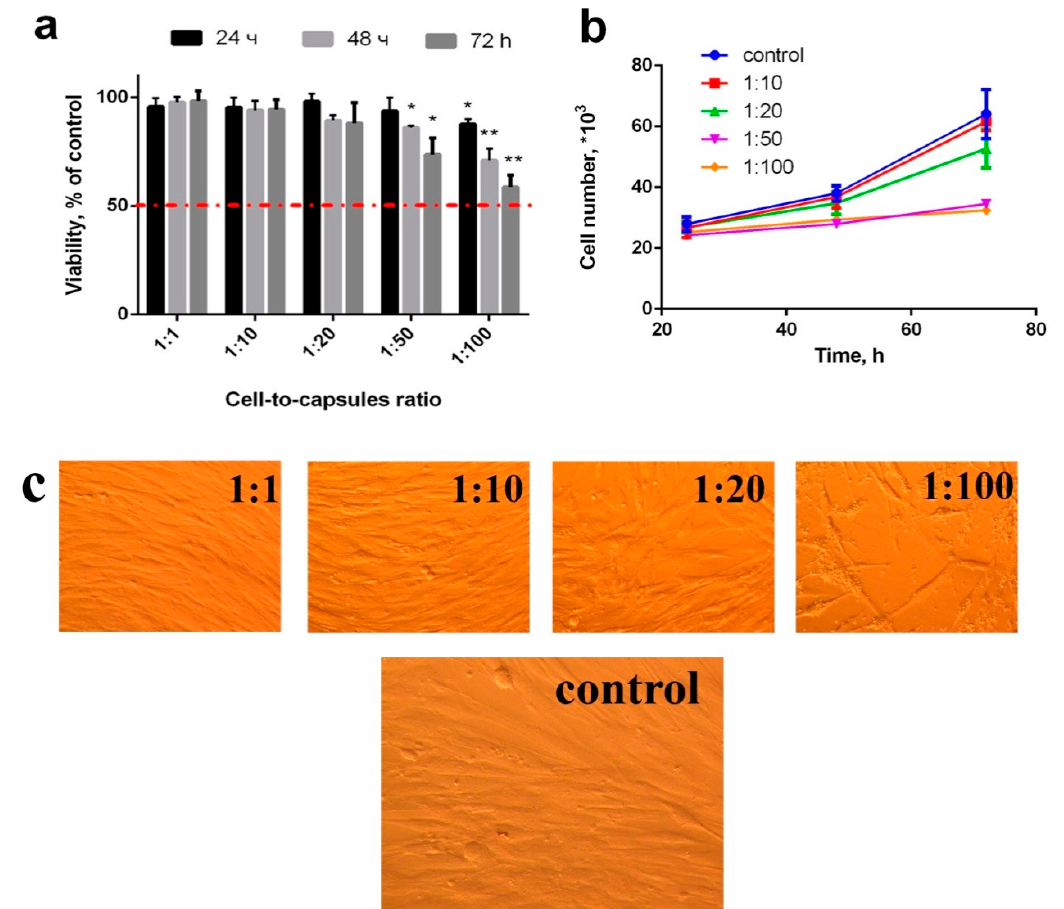
Figure 4. Viability (via MTT assay) ( a ), proliferation ( b ) and morphology appearance ( c ) of hMSC after incubation with nanoceria-loaded polyelectrolyte microcapsules. Significant differences compared with the control using the t -test with Welch’s correction, * p < 0.05; ** p < 0.0001. Control: without the addition of microcapsules.